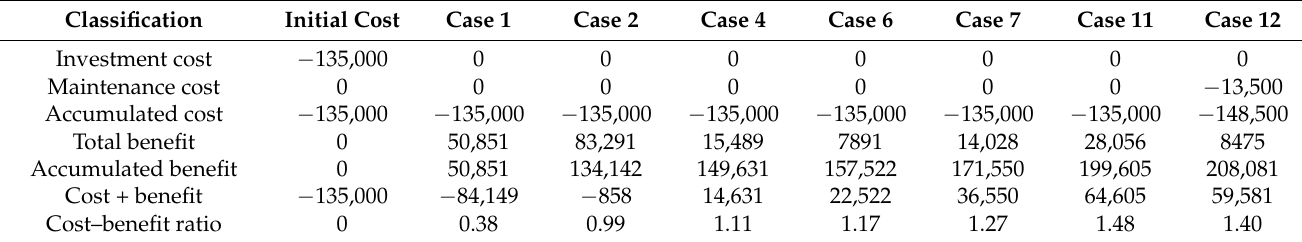
Table 6. CBA of the TLS method for 1 year (1000 KRW).